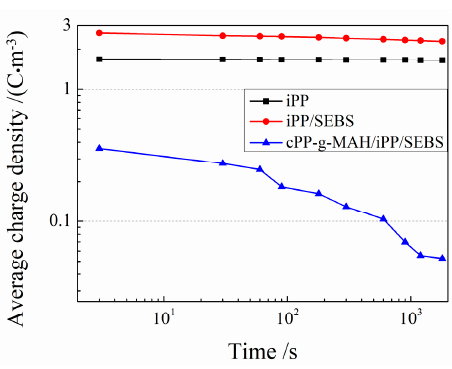
Figure 8. The average space charge density varying with time during the depolarization process.